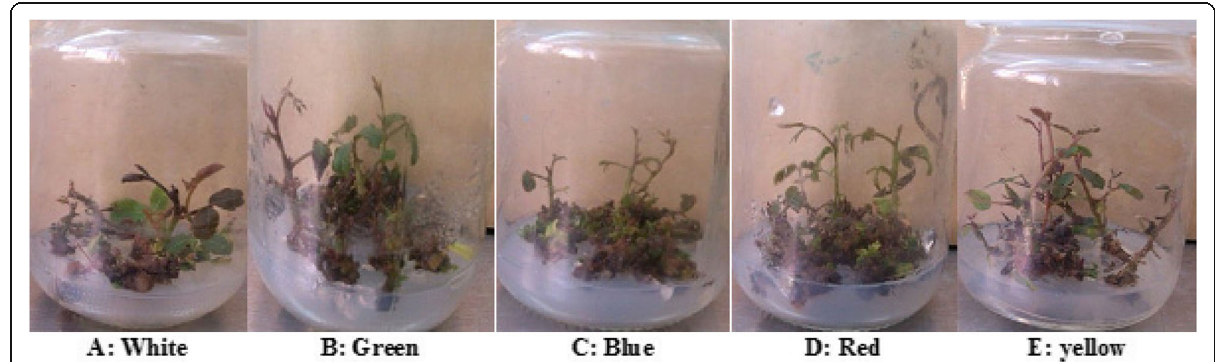
Fig. 1 Effect of light ( a white, b green, c blue, d red, and e yellow) on in vitro growth behavior of Ceratonia siliqua L. cultured on MS medium supplemented with 0.5 mg/l BA + 0.2